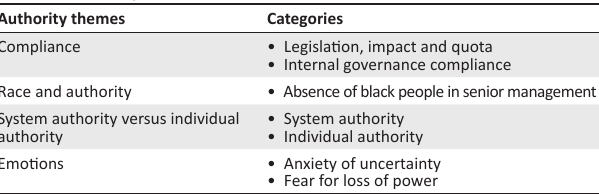
TABLE 4: Authority